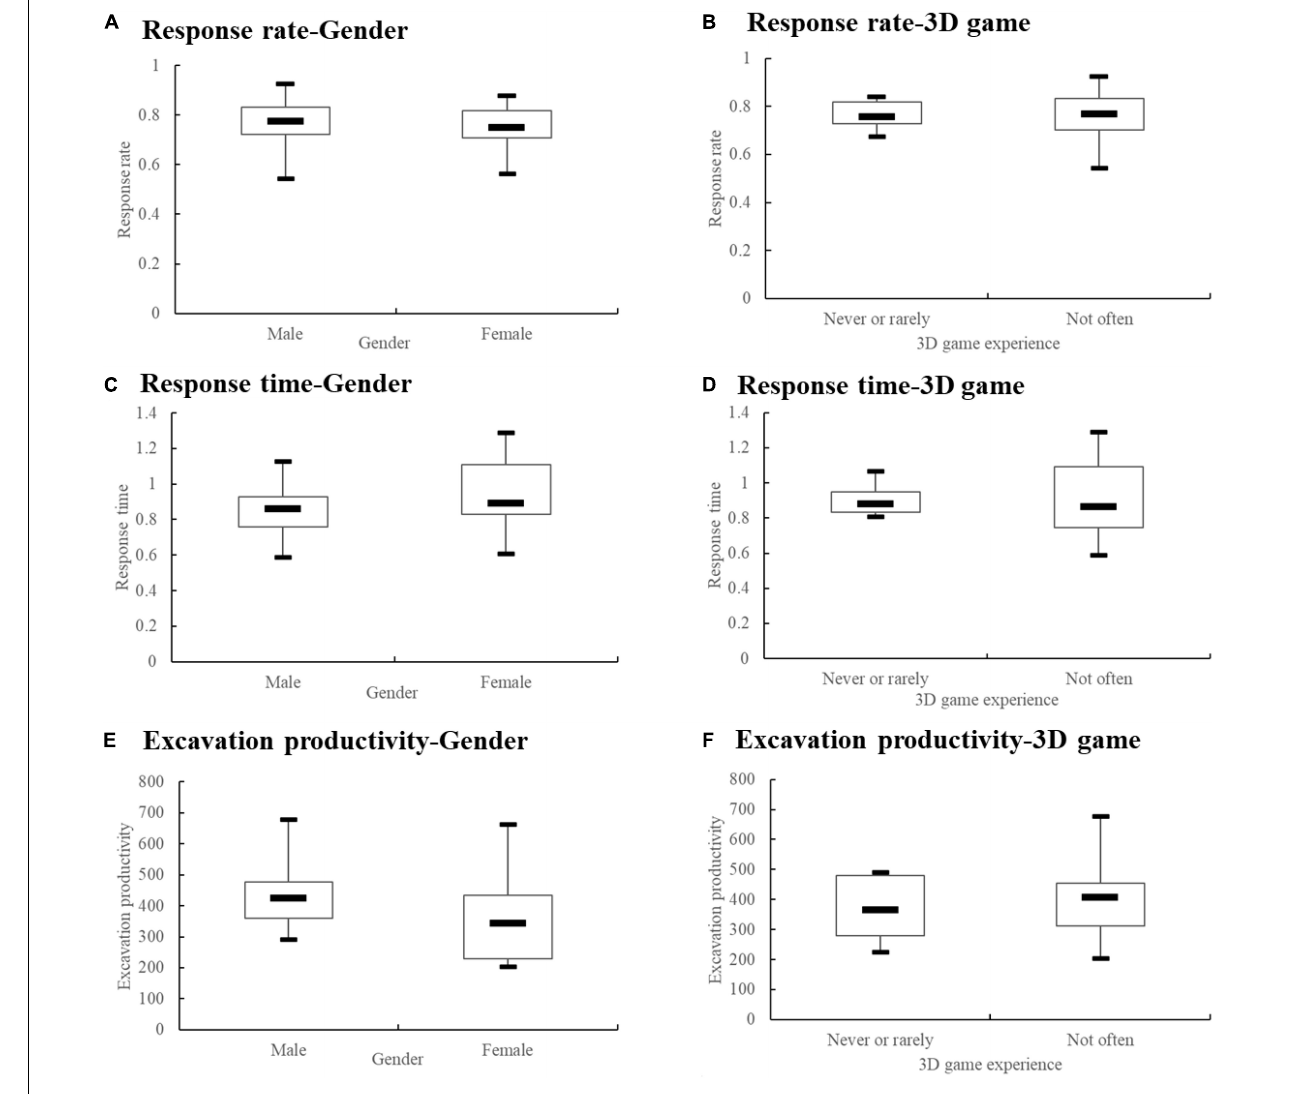
FIGURE 7 | Descriptive statistics of gender and 3D game experience.